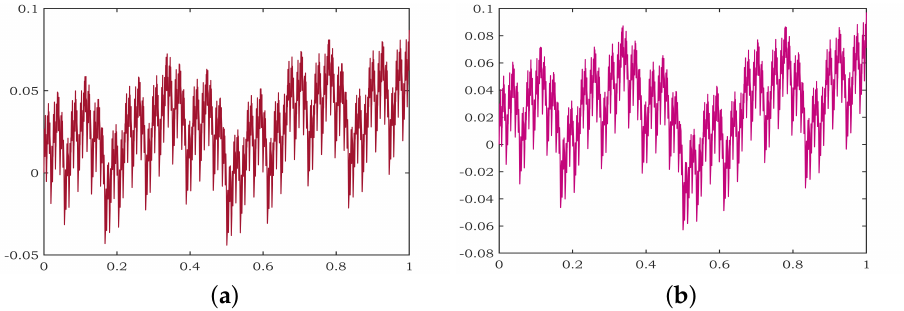
Figure 3. The RL fractional derivative: ( a ) D µ ( s ) f 1 with variable order µ ( s ) = 0.5; ( b ) D µ ( s ) f 2 with order µ ( s ) =